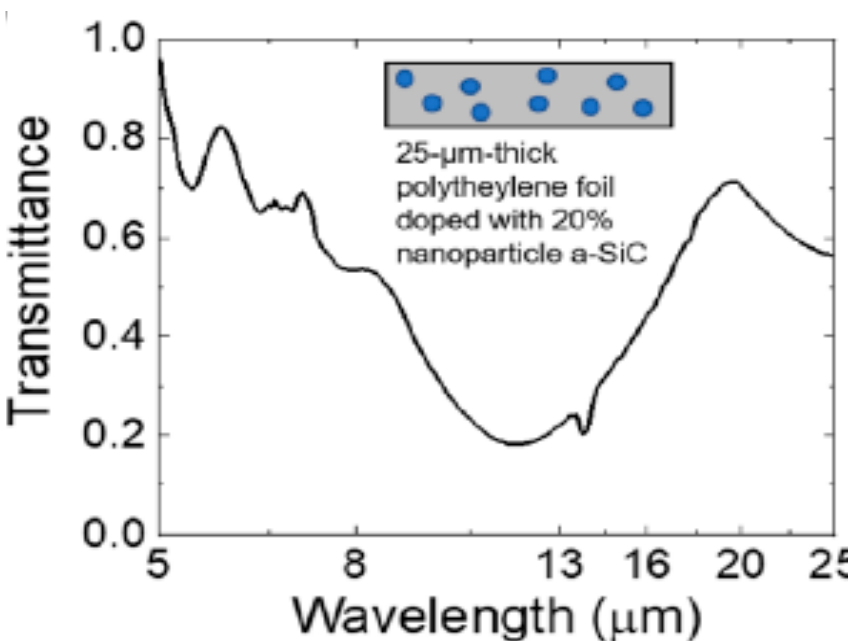
Figure 10. Polyethylene (PE) thin film with amorphous SiC nanoparticles [71].